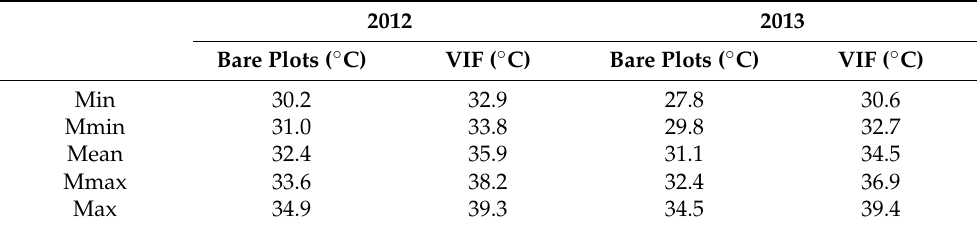
Table 2. Minimum (Min), mean of daily minimum (Mmin), mean, mean of daily maximum (Mmax) and maximum (Max) values, calculated for the soil temperature measured at 20 cm depth during the